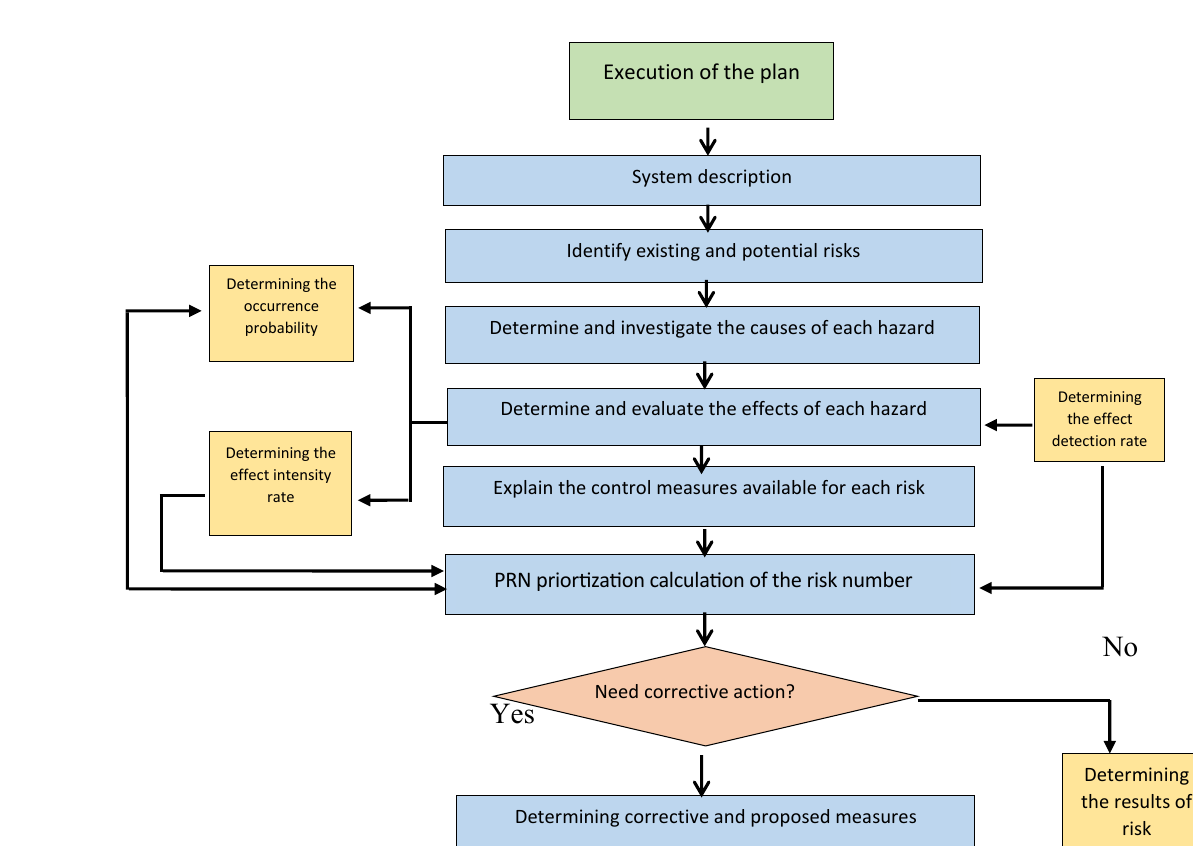
PRN priortization calculation of the risk